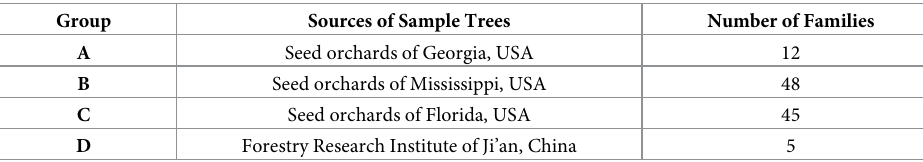
Table 1. Basic information of test materials. Group Sources of Sample